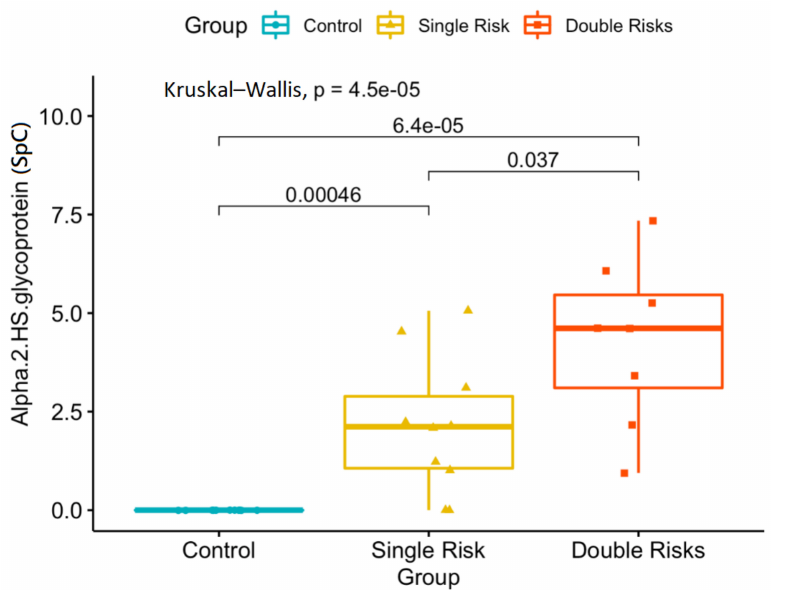
Figure 4. Proteomics analysis revealed significant concentration changes in the alpha-2-HS- glycoprotein (SpC, spectral count) among the three groups. Single risk, patients with the diabetes mellitus (DM) or smoking risk factor; double risk, patients with both the DM and smoking risk factors; control, cataract patients with neither of these cataract risk factors.